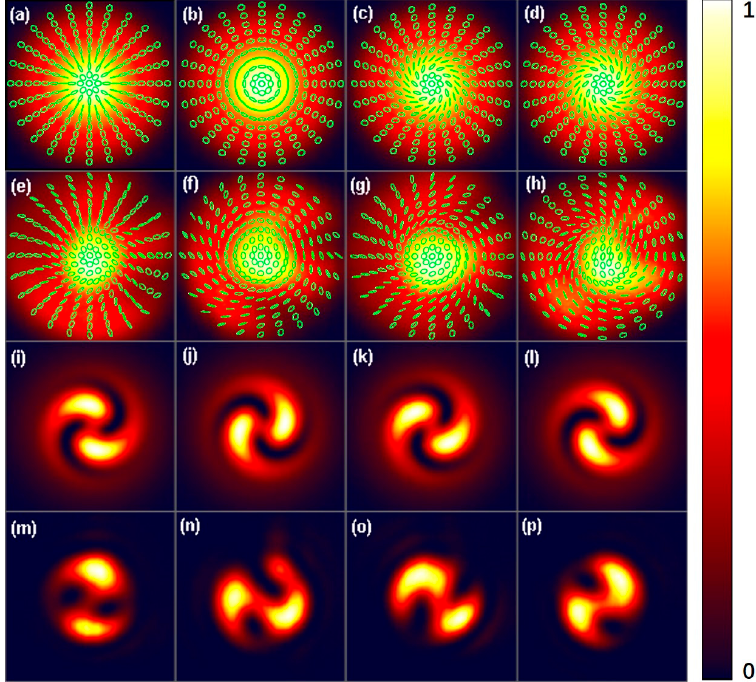
Figure 5. Polarization and intensity distributions of the generated vector vortex beams. ( a – d ) The theoretical polarization and intensity distributions for the points (1,0,0 ), ( − 1,0,0), (0,1,0), and ( 0, −1,0 ) on the hybrid-order Poincaré sphere in the order from left to right. ( e – h ) The corresponding experimental results. ( i – l ) The theoretical intensity distributions of the linearly polarized vortex beams after passing a horizontal polarizer. ( m – p ) The corresponding experimental results.